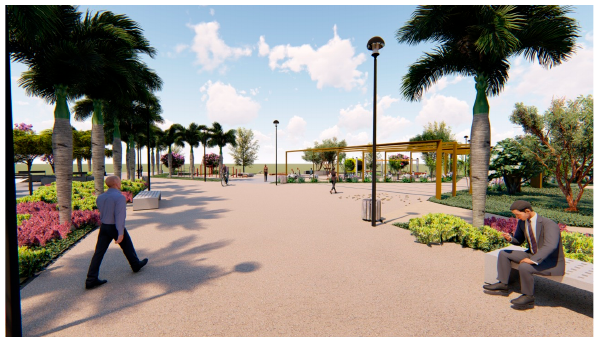
Figure 16. Centre point of the square.